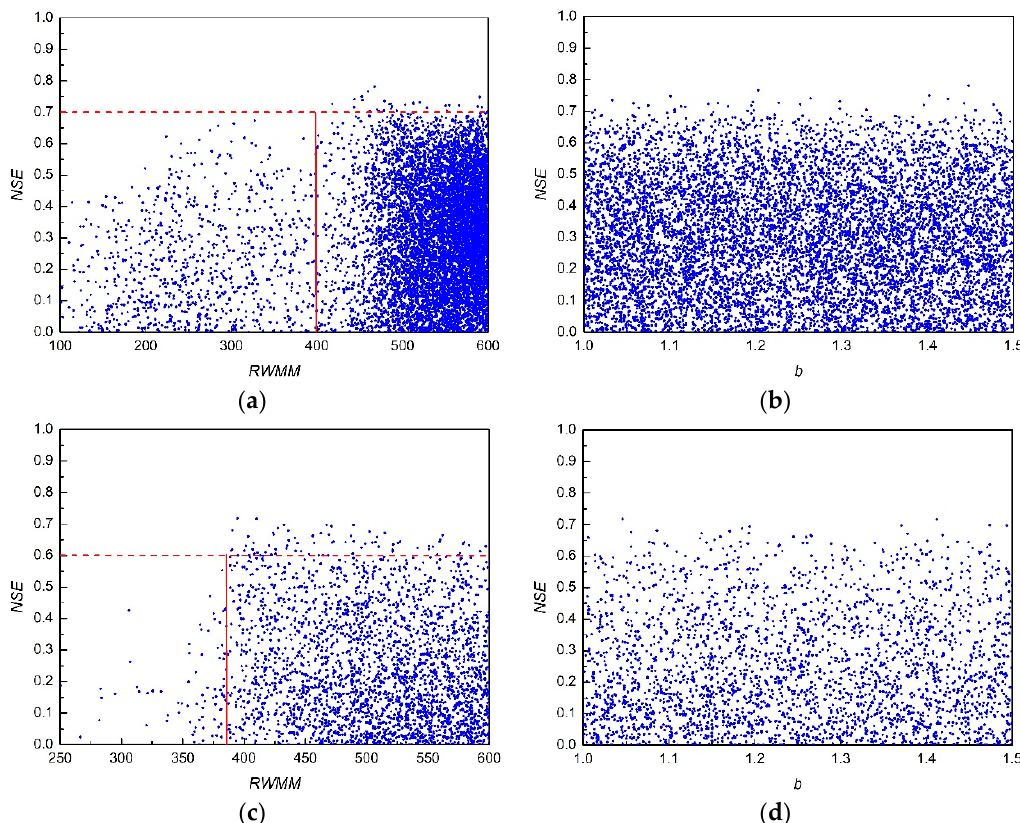
Figure 7. The relation between NSE and parameters in panels ( a , b ) for Zijingguan basin and ( c , d ) for Xiuwu